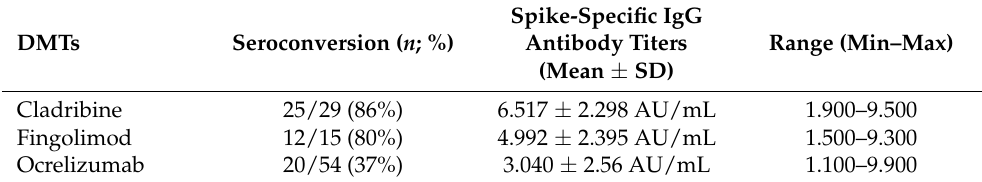
Table 2. Anti-spike IgG titers in seroconverted pwMS.